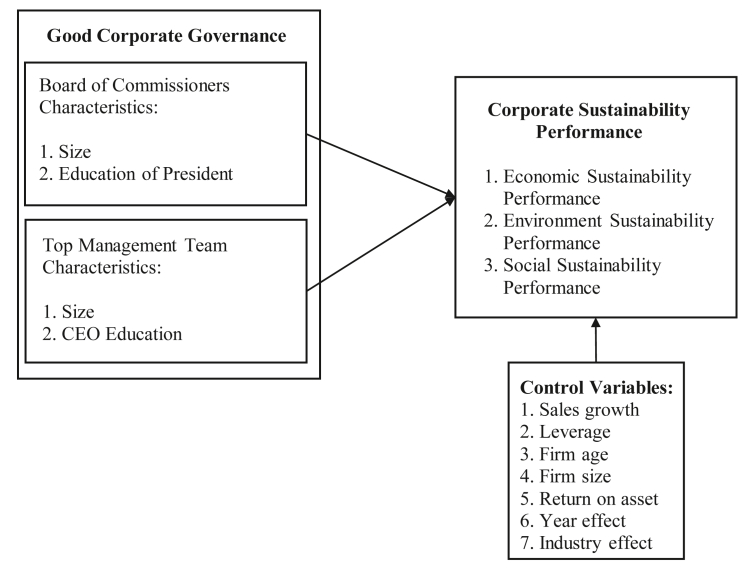
Research framework.